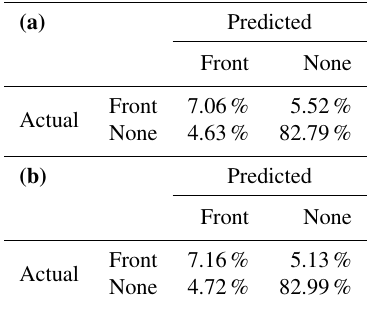
Table 4. (a) The confusion matrix as percentages of total grid cells for the simplified front/no-front categories over the 2008–2015 val- idation time range. (b) The confusion matrix as percentages of total grid cells for the simplified front/no-front categories over the 2003– 2007 training time